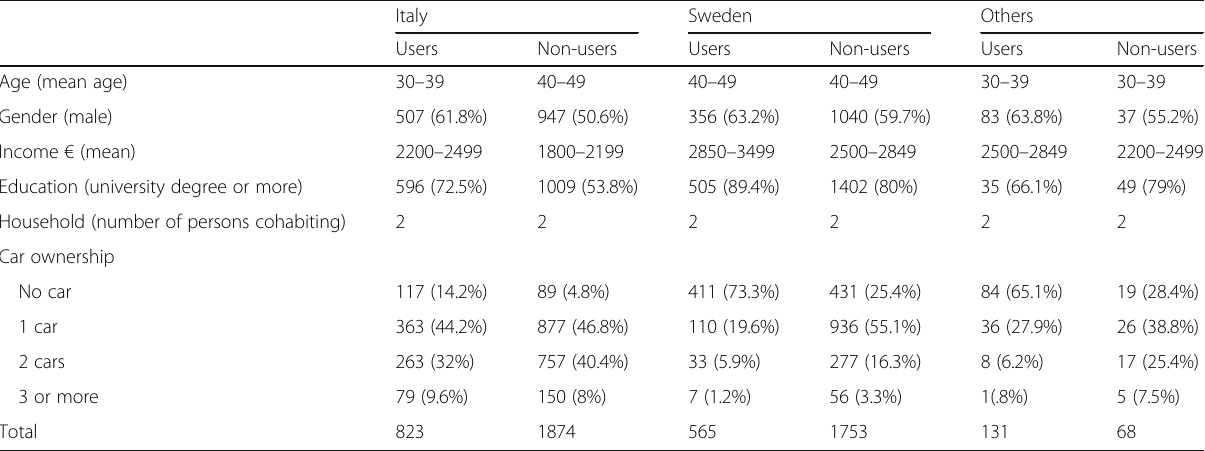
Table 2 Descriptive statistics of the sample by